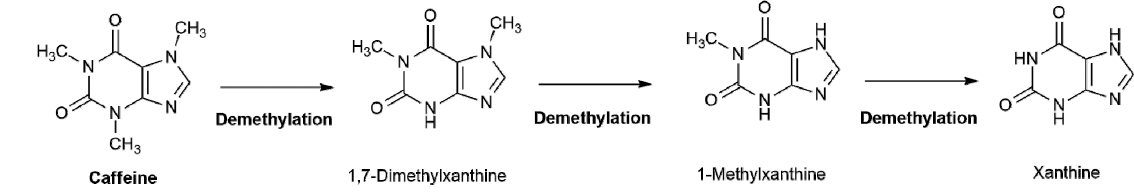
Figure 5. Possible mechanism of enzymatic caffeine degradation in spent coffee grounds under wet conditions, adapted from Gummadi et al . [35] .